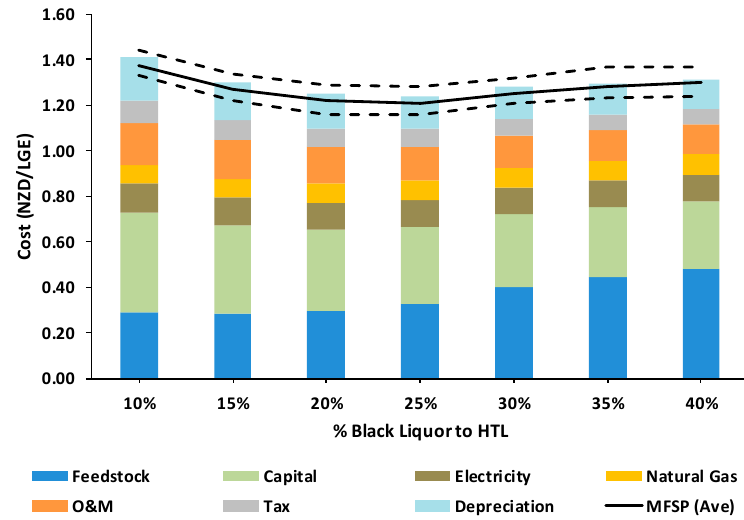
Figure 9. MFSP and the breakdown of the levelised production costs of the kraft mill-integrated HTL with MVR upgrade, with different processing size.